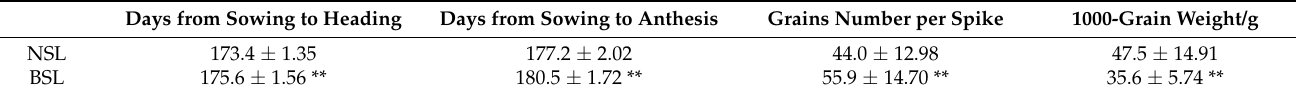
Table 2. Agronomic traits of the BSL and the NSL